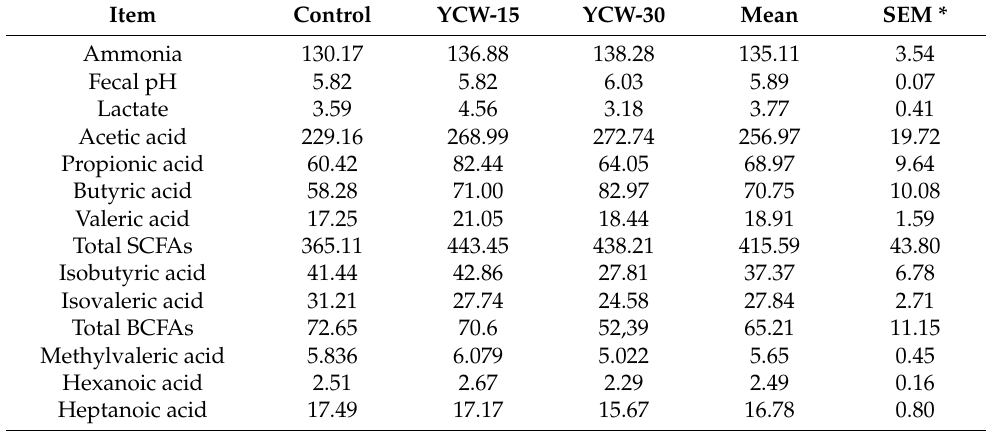
Table 4. Fecal pH and fermentation products (mmol/g fecal DM) in Exp.